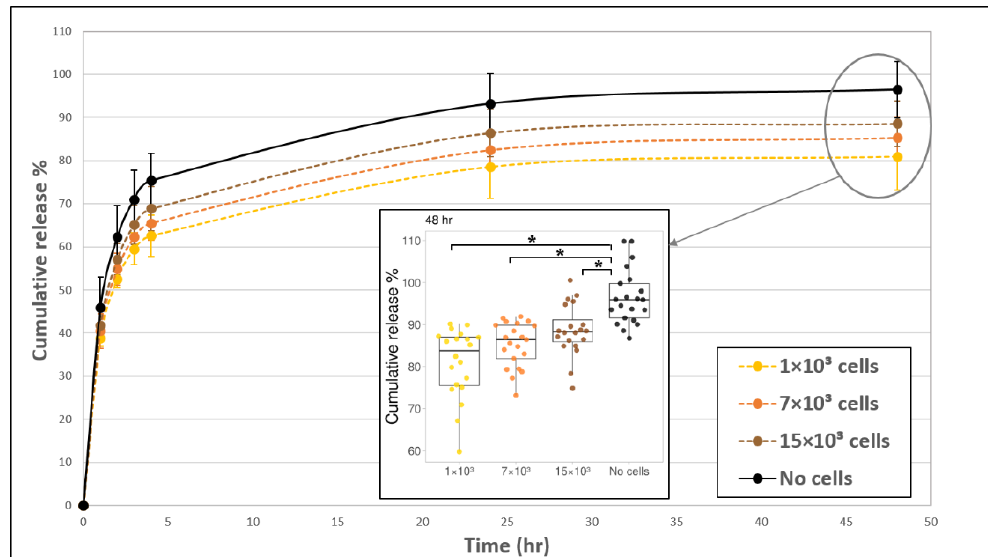
Figure 2. The addition of fibroblast cells to fibrin gels slowed down the release profile of FD 250 kDa. Fibroblast cells 1 × 10 3 (yellow, dashed line), 7 × 10 3 (orange, dashed line), and 15 × 10 3 (brown, dashed line) were seeded fibrin gels and the release profile was monitored over time. Acellular gels (black, continuous line) served as the control. The values represent the mean ± SD of 20 gels. A statistically significant difference was observed between gels with 1 × 10 3 cells versus without cells at all-time points, between gels with 7 × 10 3 cells versus without cells during 2–48 h, between gels with 15 × 10 3 cells versus without cells during 4–48 h, and between gels with 15 × 10 3 cells versus 1 × 10 3 cells during 2–24 h. Insert shows all data points at 48 h, for 20 gels of each tested condition. The boxplot shows the distribution of the experimental data with the range of variation, the interquartile range and the median. Significance with p < 0.05 is indicated by asterisks (*) in the boxplot.